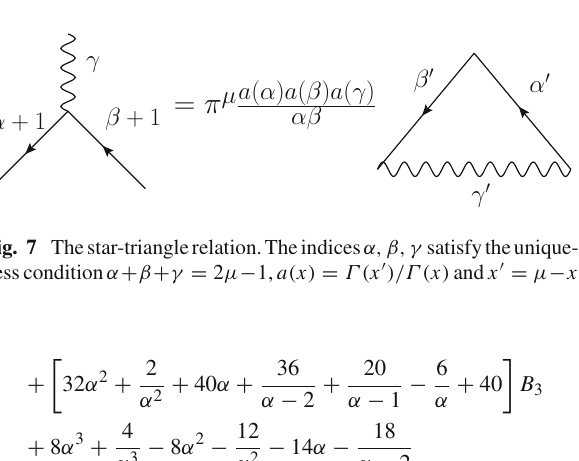
Fig. 6 Double box diagrams DB 1 (top left) – DB 4 (bottom right)